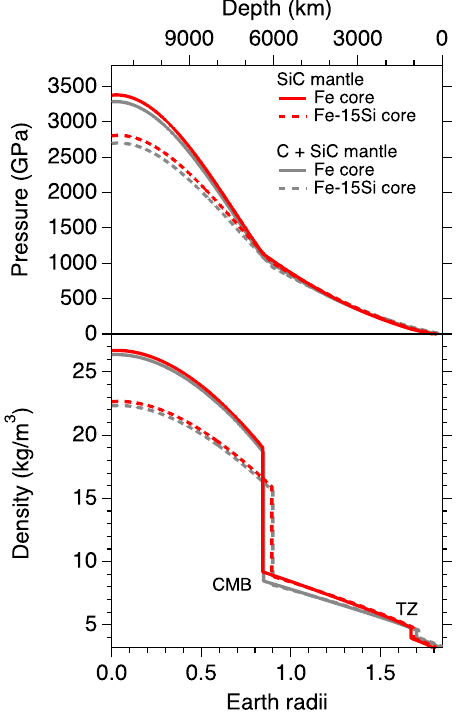
Fig. 6 Interior pressure and density for an eight-Earth-mass carbide planet. The carbide planet is modeled with a 30% by mass Fe or Fe-15wt% Si (Fe-15Si) core and a 70% SiC or C and SiC (1:1 molar fraction) mantle. The addition of Si in the core decreases pressures and densities in the core but increases core size. CMB, core-mantle boundary; TZ, transition zone (due to the B3 to B1 transition in SiC).